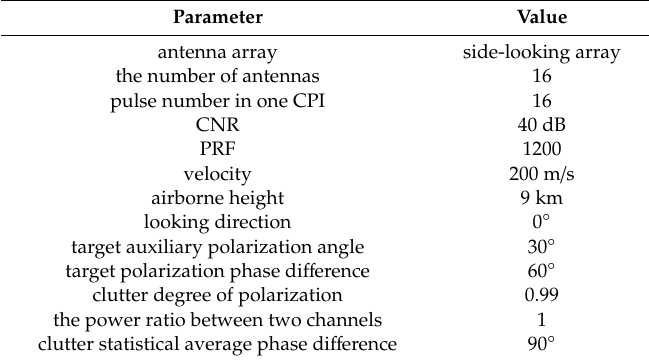
Table 1. Polarimetric radar system